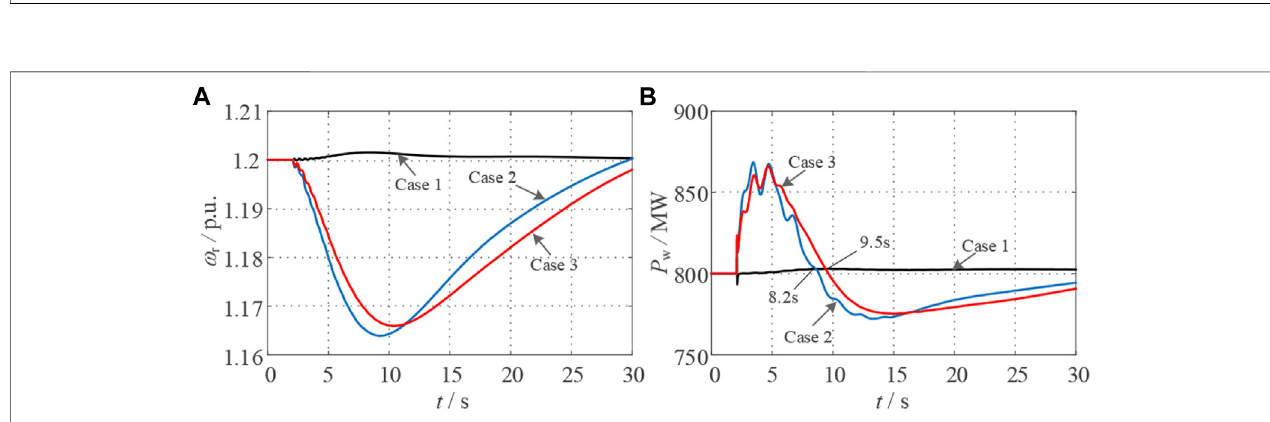
FIGURE 10 | (A) shows the output power curve of the synchronous machine G 4 after a sudden load increase, and (B) shows the output power curve of the synchronous machine